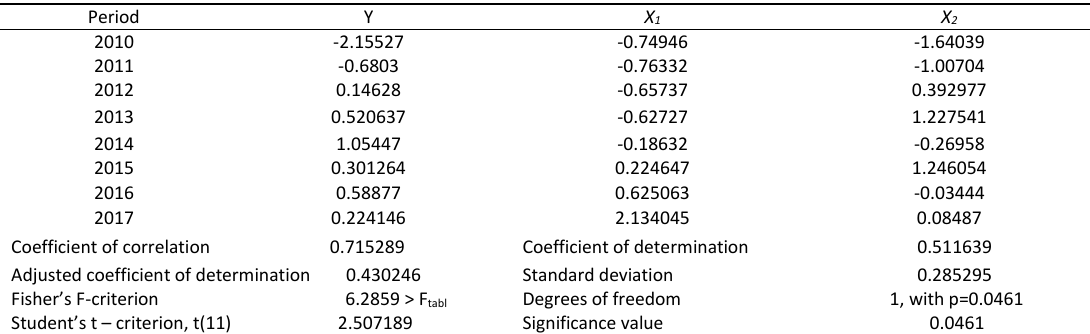
Table 6: The results of regression dependence between the crop production provision and its import volumes in Ukraine in 2010-2017 (State Statistics Service of Ukraine, 2018f; State Statistics Service of Ukraine, 2018c) Period